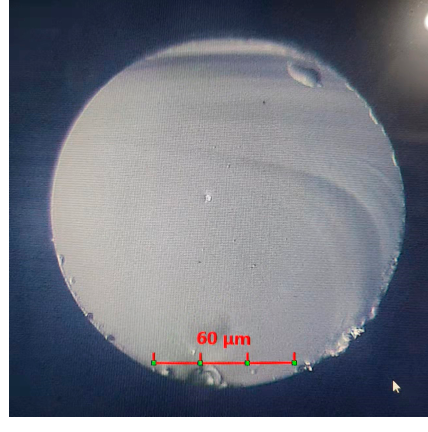
Figure 6. Harsh white light photograph of Yb 2+ -doped glass with an excitation of 405 nm. The structure of the Yb 2+ -doped fiber fabricated with rod-in-tube technology is shown in Figure 7. The fiber core was made of Yb 2+ -doped silica glass, as presented in Figure 1, and the fiber and fiber core diameters were 156.06 and 27 µ m, respectively. The refractive index profile of the Yb 2+ -doped fiber is shown in Figure 7b. The black and red lines represent the horizontal and vertical refractive index profiles, respectively. The refractive index of the immersion liquid was 1.462. The ∆ n between the fiber core and the fiber cladding was 4.26 × 10 − 4 , whereas it was 2.737 × 10 − 4 in the fiber core.